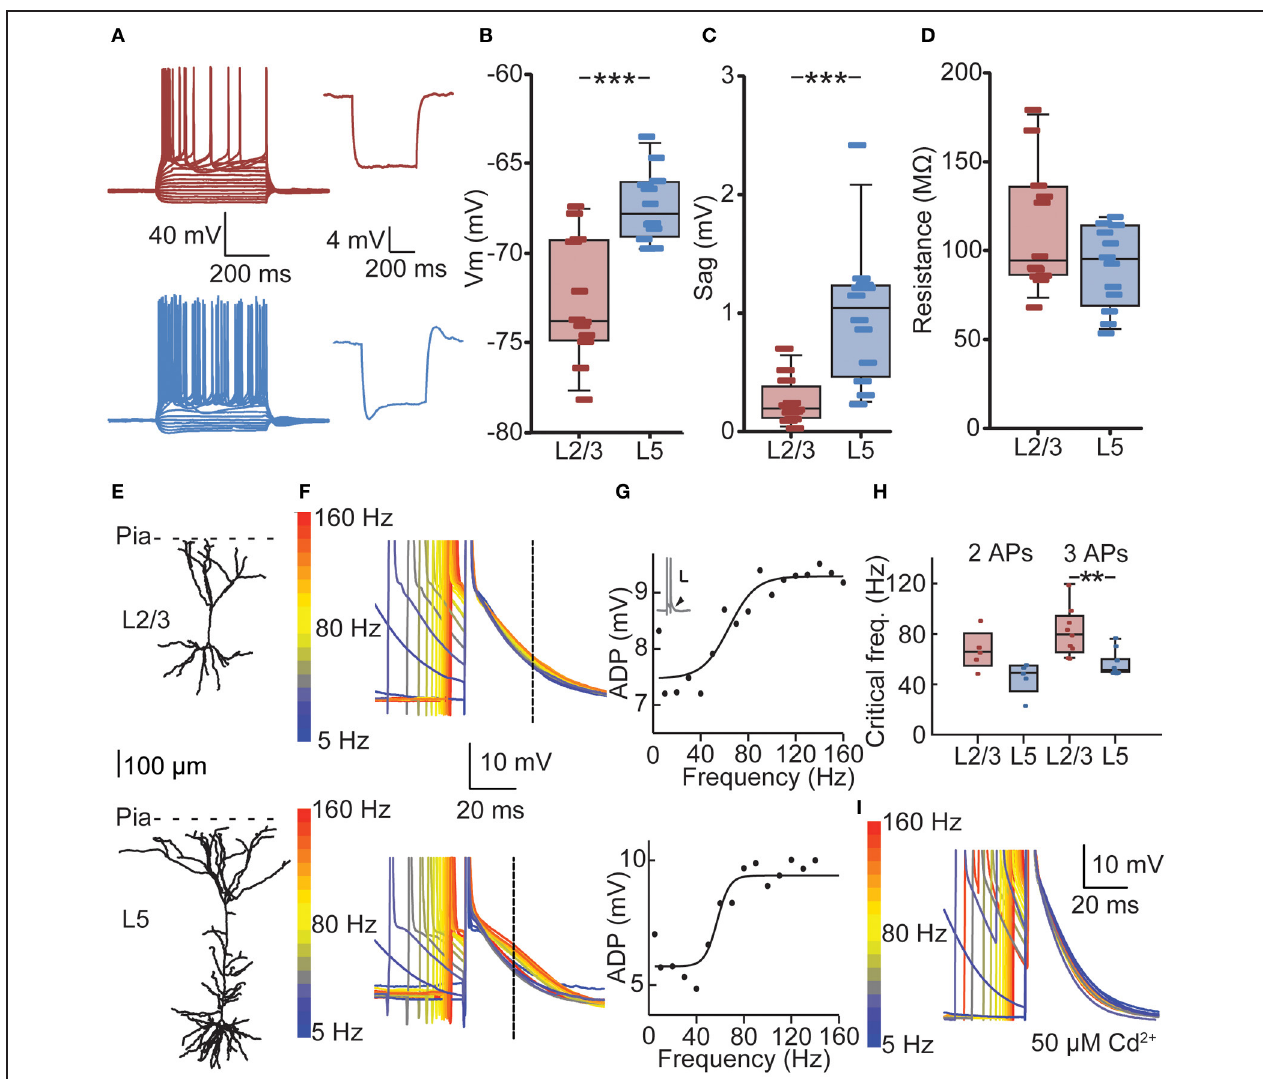
( V m , Figure 3B ) and sag amplitude (indicative of I h expres- sion, Figure 3C ), but not input resistance ( R in , Figure 3D ). More specifically, L5 neurons were significantly more depolarized than